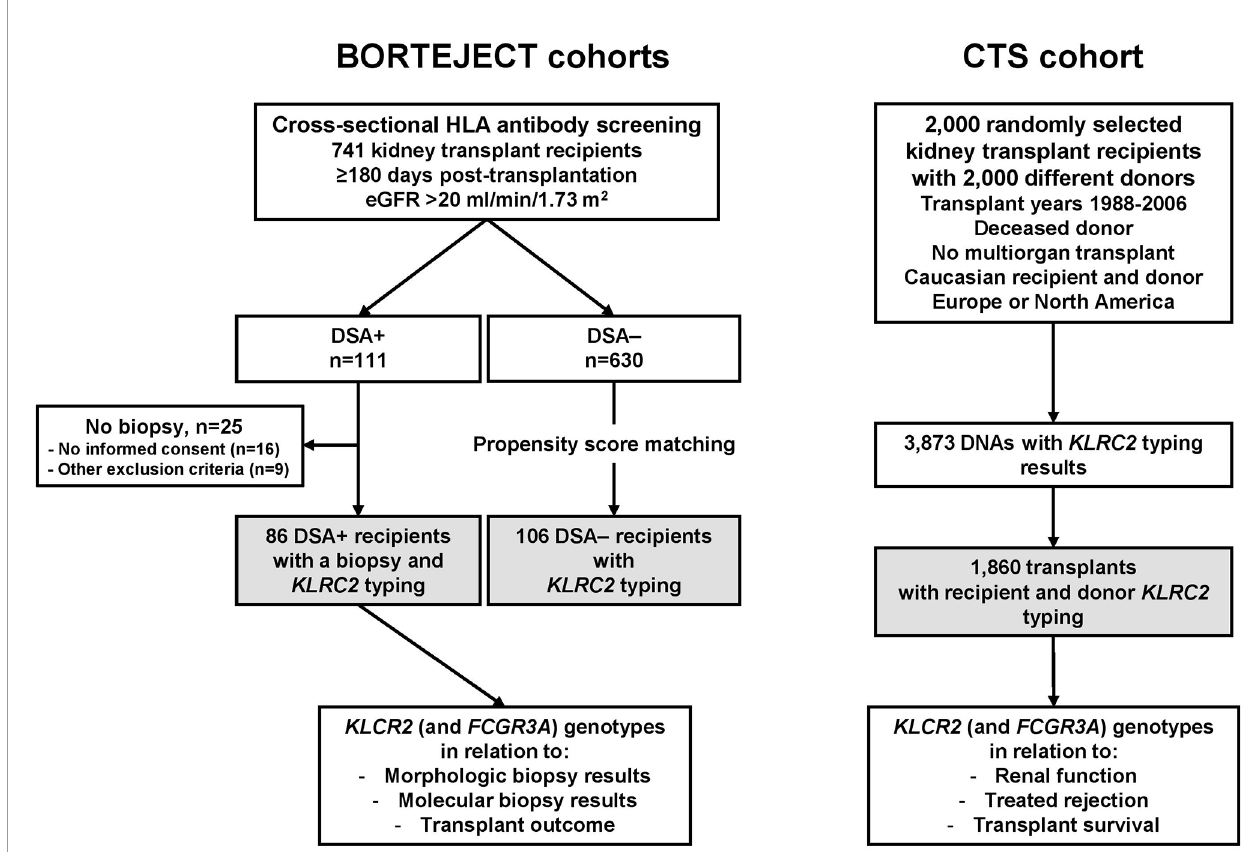
FIGURE 1 | Study fl ow chart. Systematic cross-sectional antibody-mediated rejection (ABMR) screening of a cohort of 741 kidney transplant recipients (BORTEJECT trial) led to the identi fi cation of 111 donor-speci fi c antibody (DSA)-positive recipients. Eighty-six DSA+ patients underwent protocol biopsies. For all 86 subjects (primary study cohort) adequate material for KLRC2 genotyping was available. A control group of 106 recipients was de fi ned by propensity score matching as described in the methods section. A large prospective multicenter cohort (Collaborative Transplant Study, CTS; 1,860 recipient/donor pairs) was included to assess associations of genotyping results in relation to long-term allograft outcomes. eGFR, estimated glomerular fi ltration